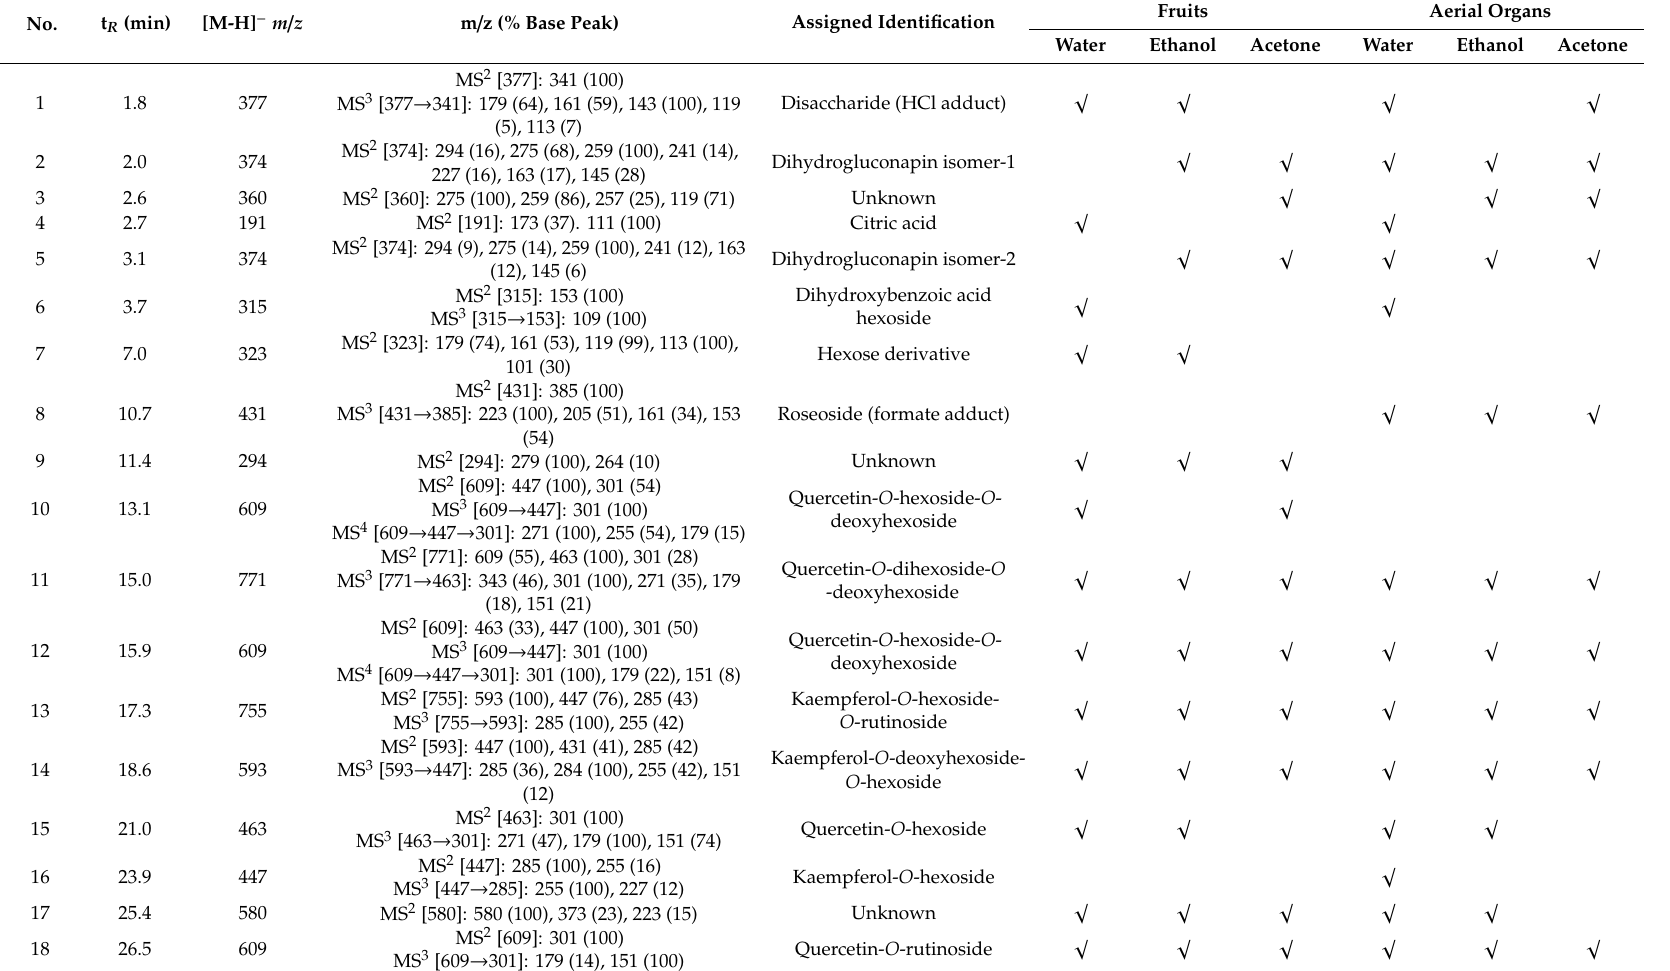
Table 2. Qualitative profile of the compounds present in extracts from aerial vegetative organs and fruits of sea rocket ( Cakile maritima ). No. t R (min) [M-H] − m / z m / z (% Base Peak) Assigned Identification